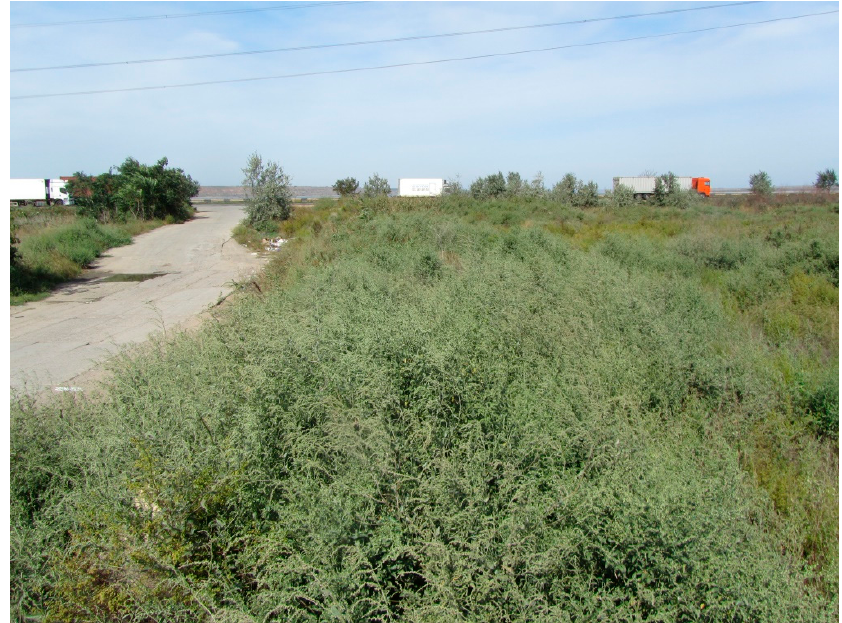
Figure 15. The Vegetation of near dam areas of ponds. Atriplicetum hastatae community is in the foreground (southern part of the Estuary).